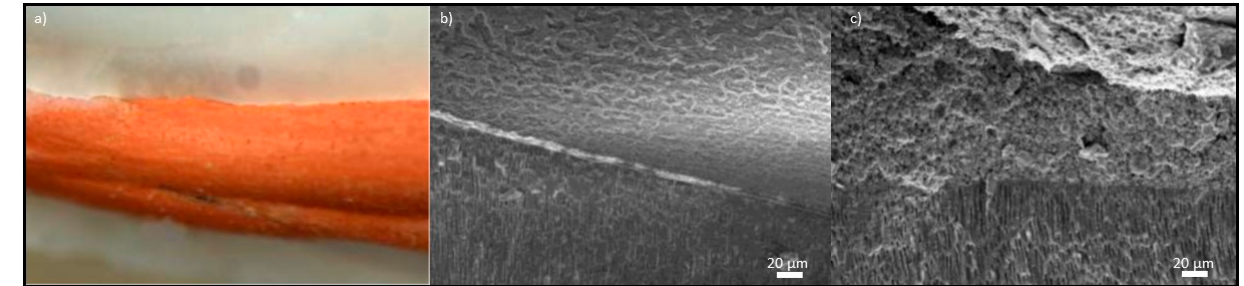
Figure 10. Tight connection of the material on the matrix of gutta-percha, evenly covered with an intermediate layer of sealant and the dentin of the root canal. ( a , b ) After thermoplastic condensation of the filling material: ( a ) longitudinal breakthrough, LSM; ( b ) visible course of the tubules, viewed using SEM; ( c ) after thermoplastic condensation with THC, the filling material has been placed with a visible cross-section of the dental tubules, viewed using SEM.